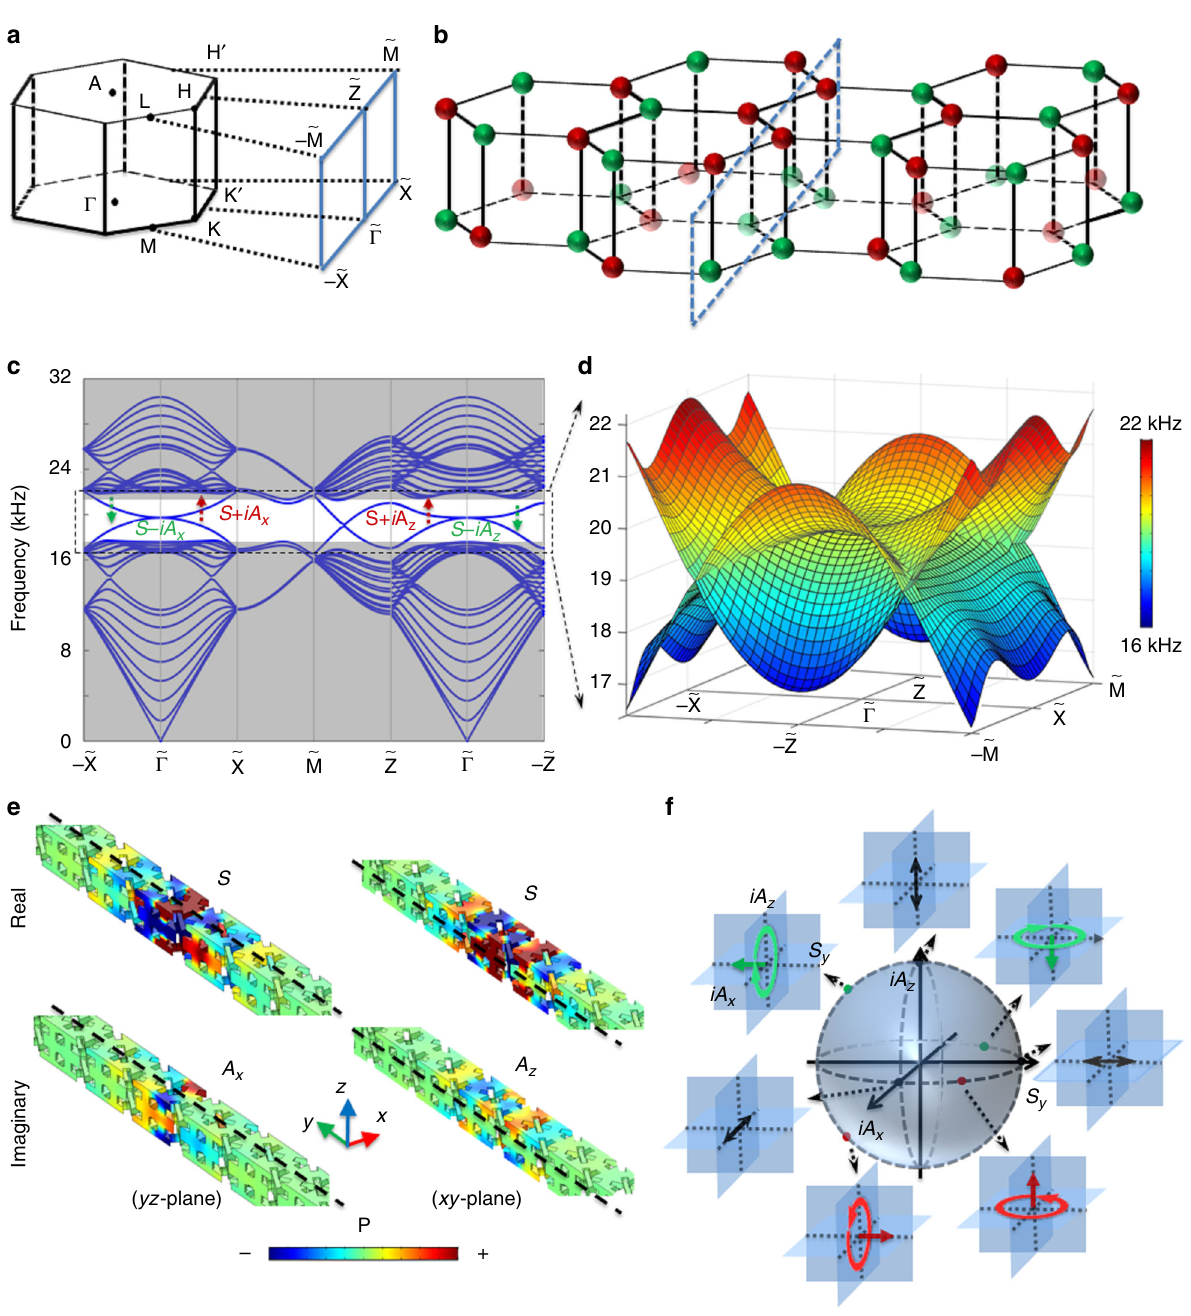
Fig. 2 Topological pseudospin-valley states with saddle surfaces. a One - half of the surface BZ projected onto the k xz plane. b The schematic of the interface. c Numerical results for the projected band structures along the high symmetric directions of the surface BZ. The shadow regions indicate the bulk pass bands. d Zoom-in surface states for the whole surface BZ. e Acoustic pseudospins (marked in c ) are hybridized by symmetric ( S ) and anti-symmetric ( A ) states with ± π /2 phases delay, forming S ± iA . f Acoustic pseudospin sphere on the base of S (noted as S y ), iA x and iA z states, where red and green circles represent opposite chirality, and the corresponding arrows represent